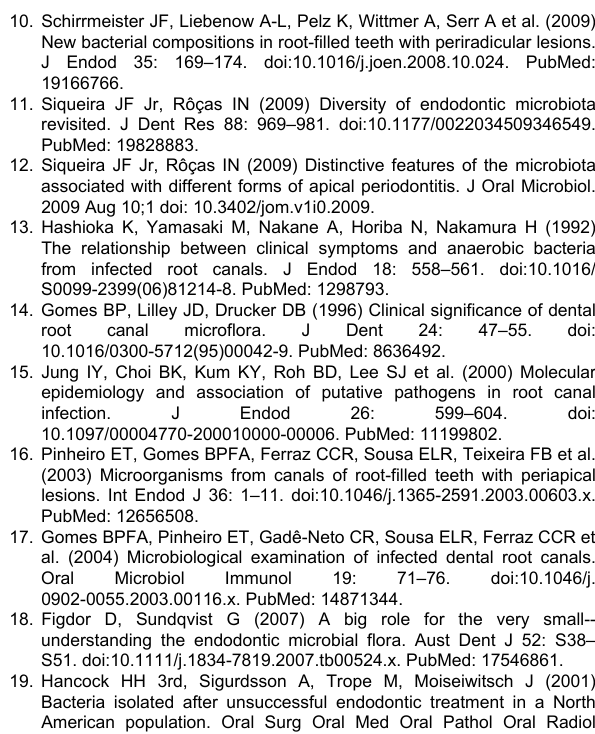
Table S2. Excel file with OTUs at 3% dissimilarity, A) and OTUs at 5% dissimilarity; B) found in 40 samples of root canal treated teeth.